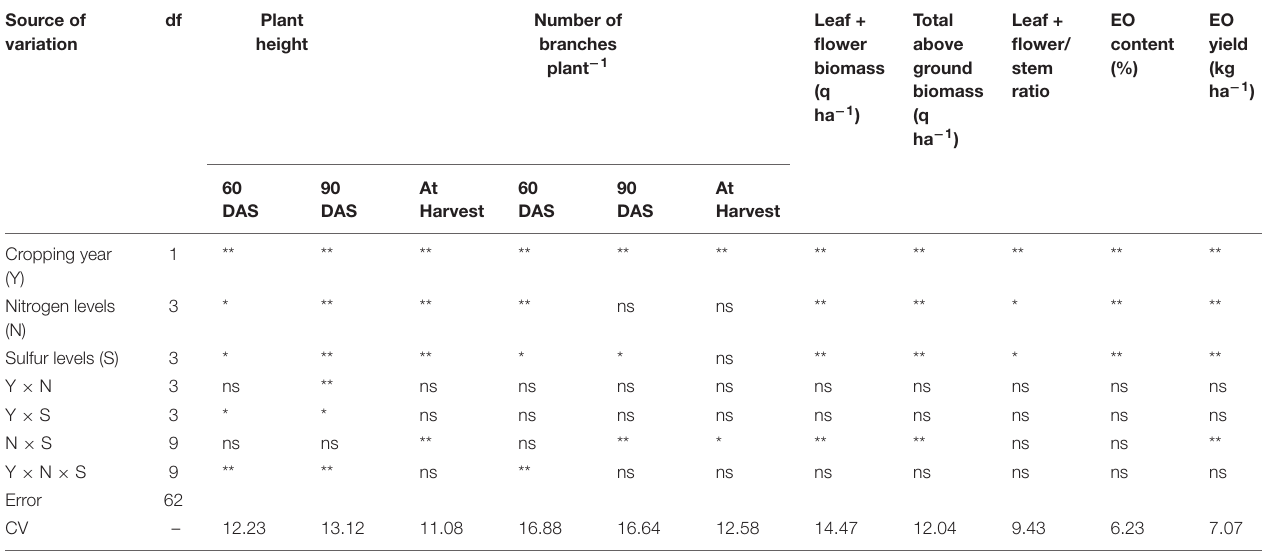
TABLE 1 | Analysis of variance for effect of cropping year and nutrient application on growth and yield traits of T. minuta . Source of df variation